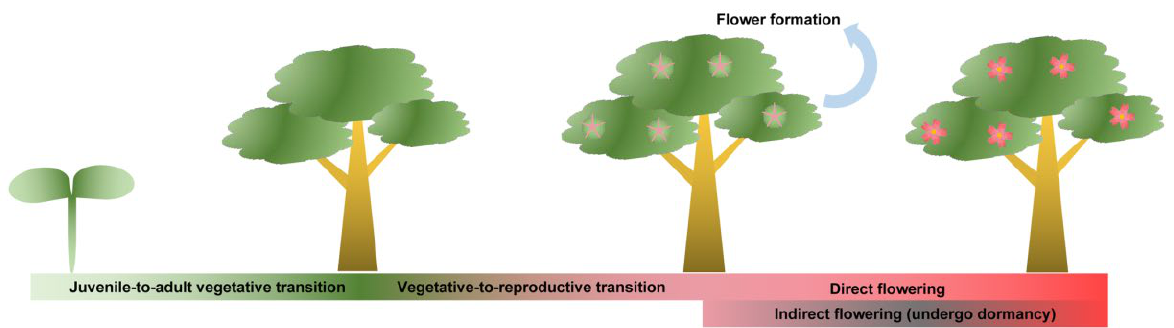
Figure 1. Schematic presentation of flowering phenology in woody trees. The juvenile-to-adult vegetative transition refers to a long period before woody trees first acquire flowering ability; the vegetative-to-reproductive transition commonly shows repeated cycling or rather seasonal periodicity, indicating flower formation follows the floral transition; “Direct flowering” refers to trees that finish their complete reproductive cycle during a single growing season without a dormancy period, while “indirect flowering” means the trees undergo winter dormancy before final blooming. Table 1. Time of juvenile-to-adult vegetative transition in several representative woody trees. Tree Species Tree